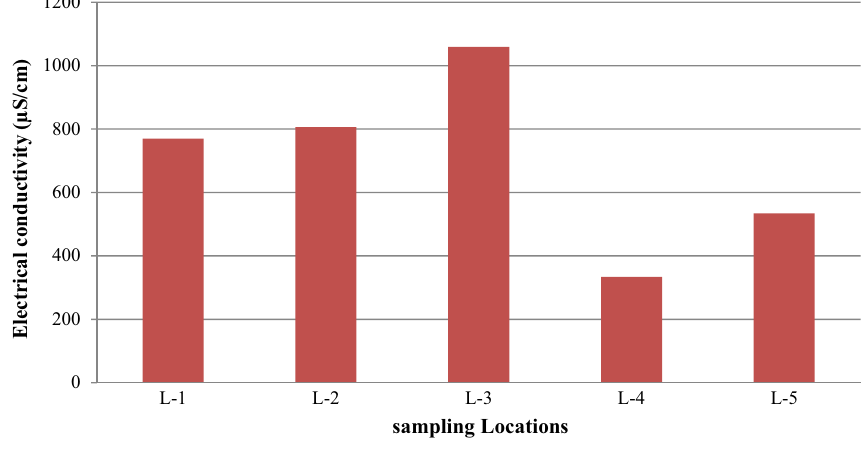
Fig. 5 Variation of electrical conductivity at different sam- pling locations of the study area